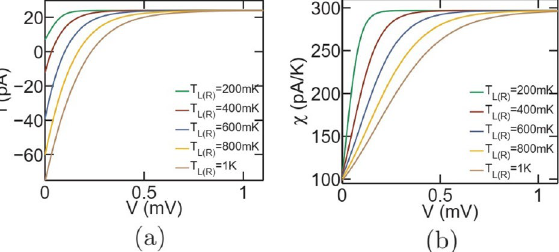
Figure 3. Current based thermometry in the dual-dot set-up depicted in Fig. 1a. Variation in ( a ) total current with applied bias V for different values of T L ( R ) . For the above set of plots, ( b ) temperature sensitivity (cid:31) χ = dI dT G (cid:30) the parameters employed are U m = 100 µ eV and T G = 300 mK, while the ground states of S 1 and G 1 are pinned at the equilibrium Fermi energy, that is ξ 1 s = ξ g = µ 0 . Given sufficiently high bias voltage V , the total current as well as temperature sensitivity χ = (cid:31) dI dT saturate to the same value for different T L ( R ) G (cid:30)